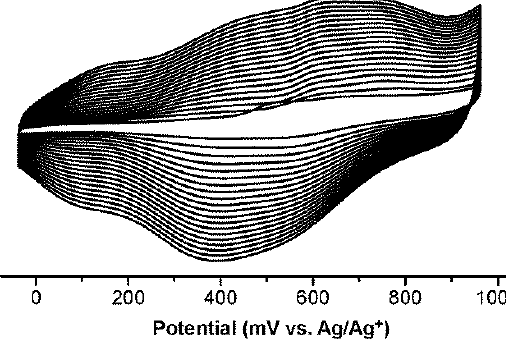
Figure 7. Growth of polymer P[T5] with potential cycling.